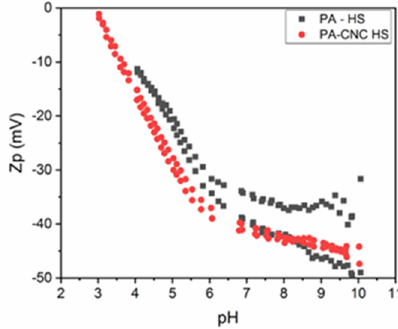
Figure 1. Zeta potential for both the modified (PA-CNC) and the unmodified (PA) membranes.